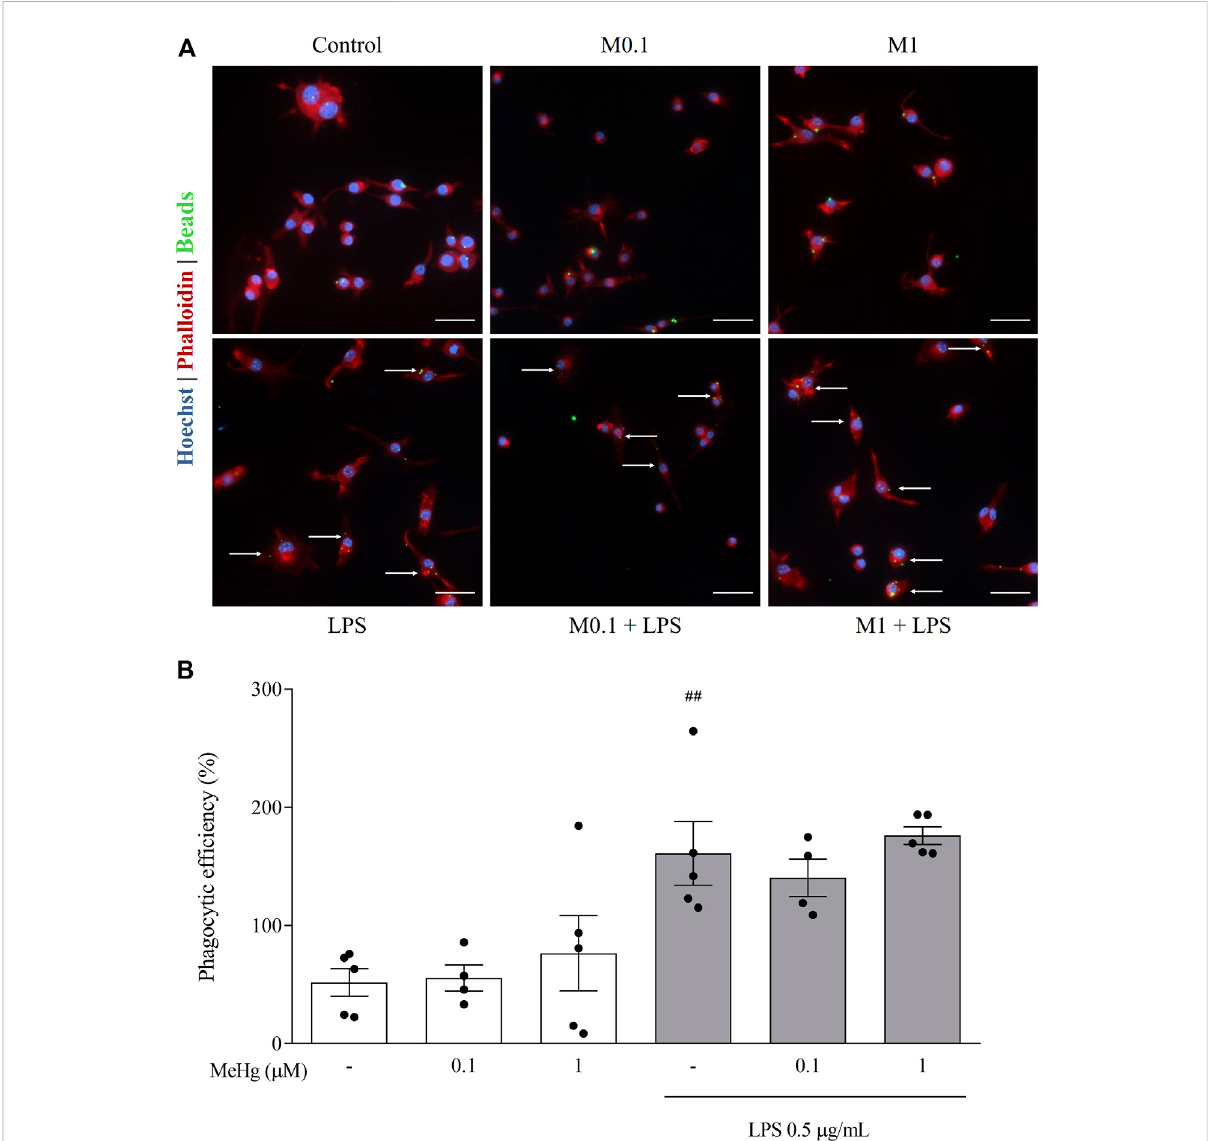
FIGURE 5 EffectofMeHgexposure(0.1,and1 µM)onthephagocyticpro fi leofBV-2microglialcellsexposedfor1 handsubsequentlystimulatedwithLPS for 6 h, obtained through Phagocytic activity assay. (A) Representative images of BV-2 phagocytosis activity labelled with Hoechst 33342 (blue), Phalloidin (red) and fl uorescentbeads(green).Arrowsshow cellswith internalizedbeads. Scalebars, 50 µm. (B) Assessmentofphagocytic ef fi ciency of BV-2 microglial cells. ## p < 0.01 vs. Control. Data are expressed as Mean ± SEM, n = 5. One-way ANOVA with Bonferroni ’ s multiple comparisons